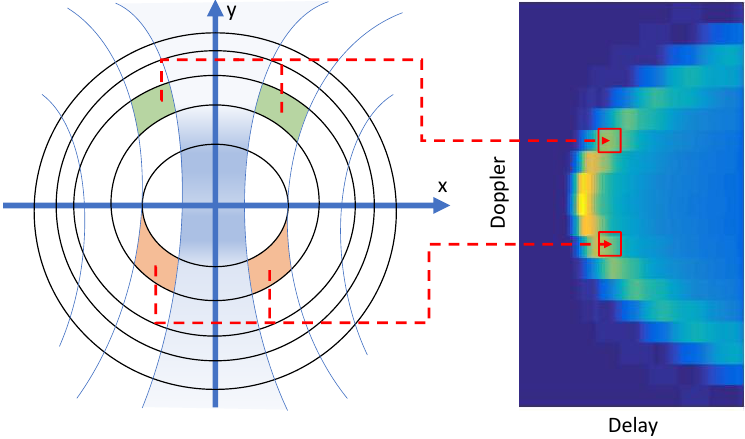
Figure 3. Illustration of the ambiguity problem in mapping the power from the spatial domain ( left ) to the delay-Doppler domain ( right ). In the left panel, blue curves are equi-Doppler and black ellipses are equi-range. As shown, each delay-Doppler Map (DDM) pixel is not proportional to scattered power from only one pixel in the spatial domain, but from a pair of pixels located symmetrically with respect to the intersection of the incidence plane with the ocean surface, which is the y-axis in the illustrated